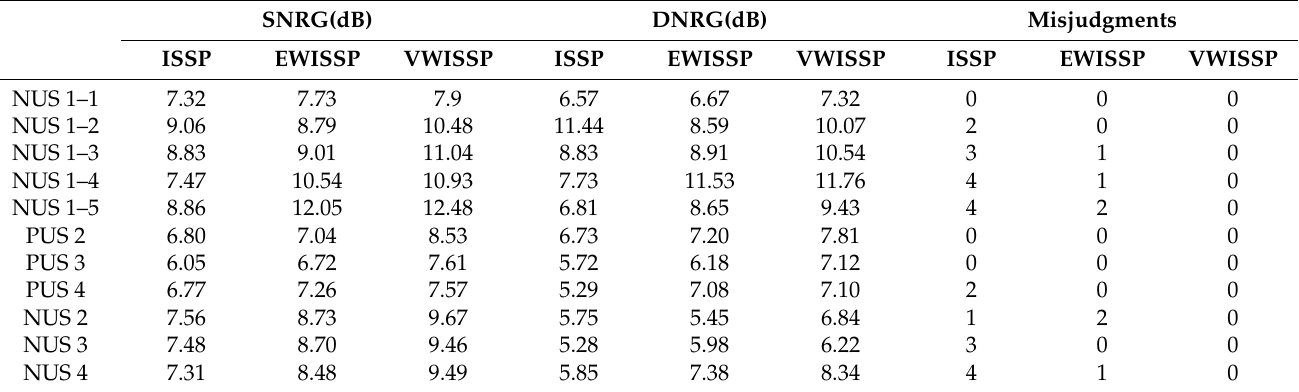
Figure 12. Sparse signals of ( a ) single-defect NUS signals and ( b ) multi-defect N/PUS signals processed by EWISSP and VWISSP. Table 1. SNRG, DNRG, and misjudgments of N/PUS signals processed by ISSP, EWISSP, and VWISSP.